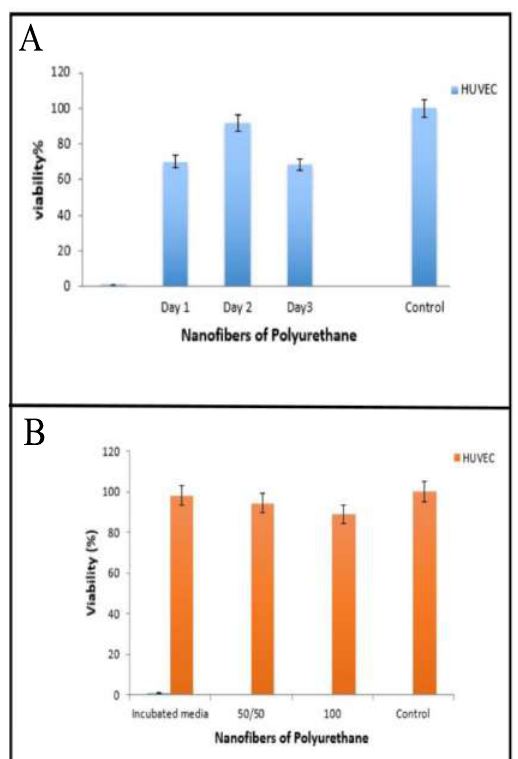
Fig. 3. (A) Direct MTT results obtained after culturing HUVEC cells on nanofibers for 24h, 48h and 72 hours. (B) Indirect MTT results which scaffolds was kept in a complete media for 10 days. Then HUVEC cells which are cultured inside TCP, treated by incubated media at 2 different proportion of fresh and incubat- ed culture media. After 48 hours, HUVEC cells underwent to MTT